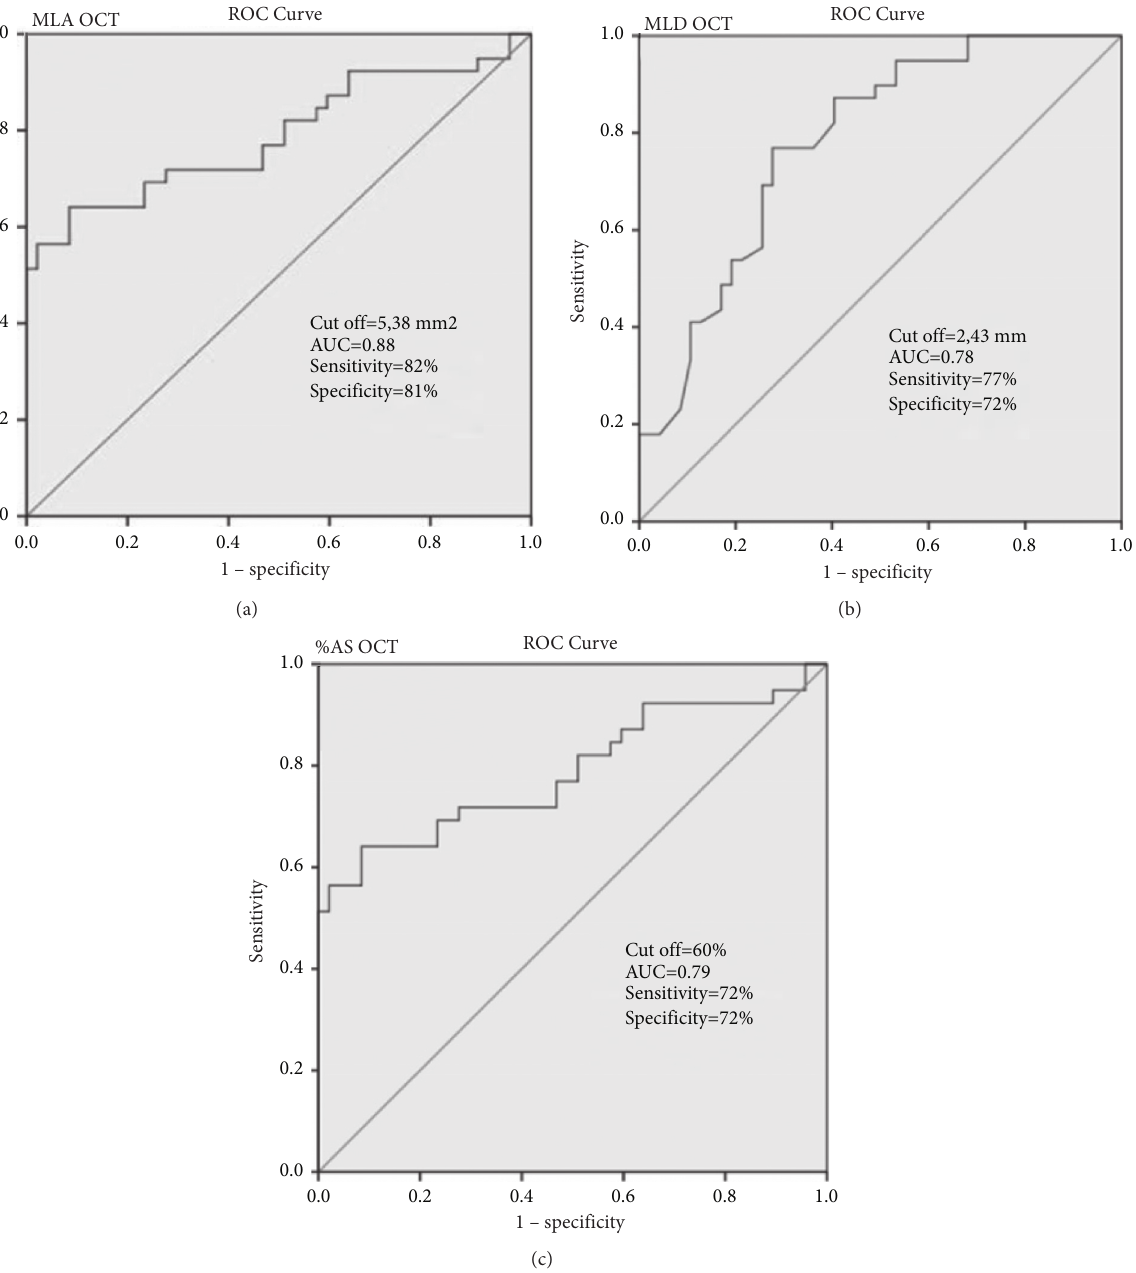
Figure 3: Receiver operating characteristic (ROC) curves. (a–c) ROC curves for OCT-derived MLA, MLD, and % AS to predict FFR ≤ 0.80. The abbreviations are as in Figure